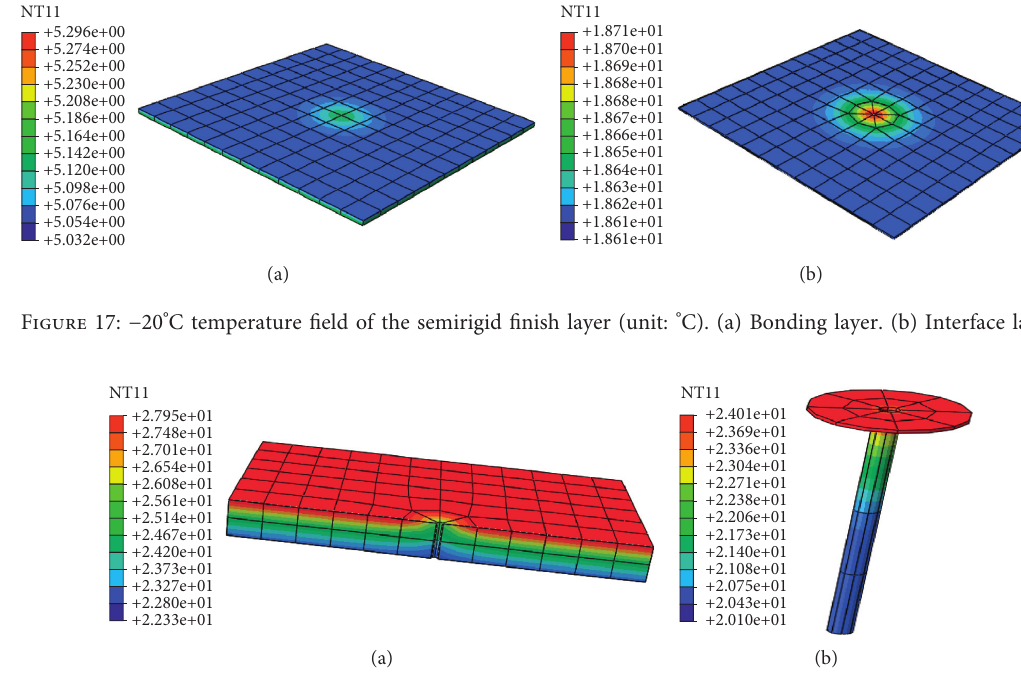
Figure 18: 50 ° C temperature field of the semirigid finish layer (unit: ° C). (a) Insulation layer. (b) Bushing.